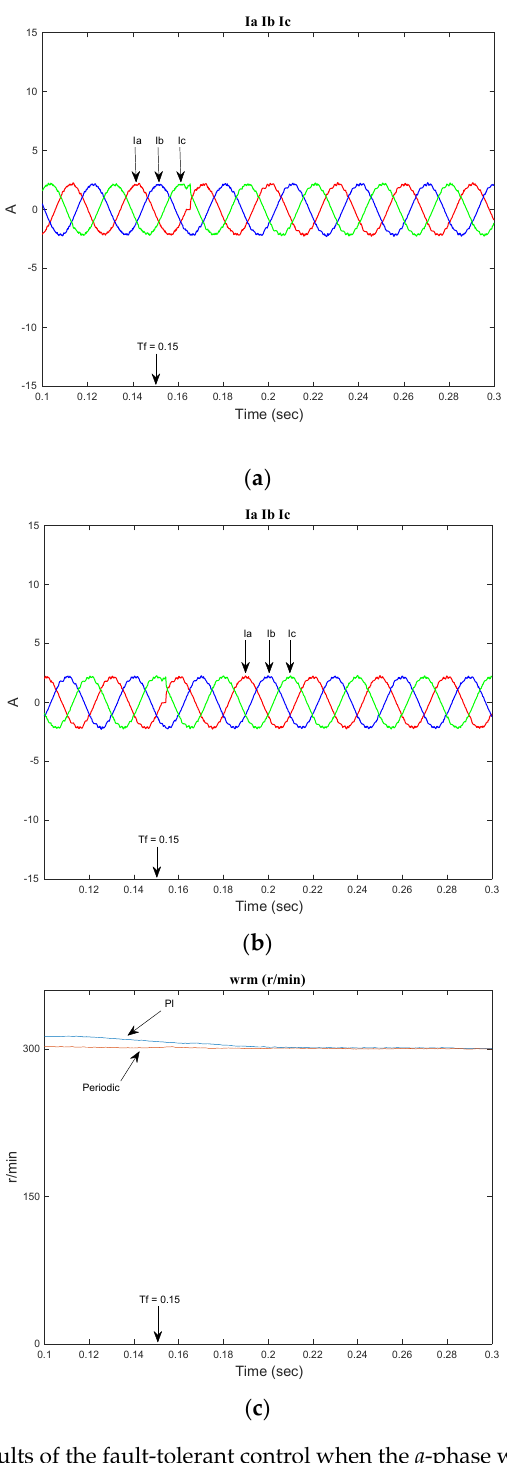
Figure 14. Simulated results of the fault-tolerant control when the a -phase was open-circuited in d–q inductance asymmetry conditions: ( a ) currents of the speed-loop PI controller; ( b ) currents of the speed-loop periodic controller; ( c ) speed responses.